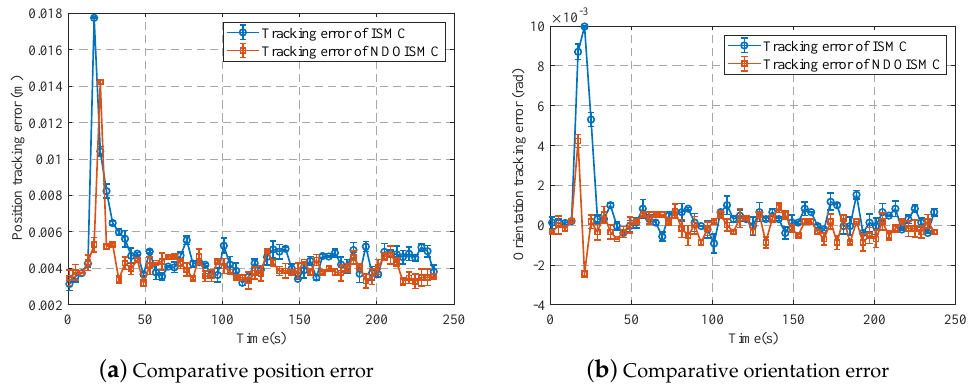
Figure 7. Experimental comparison result for Case A: normal floor surface.